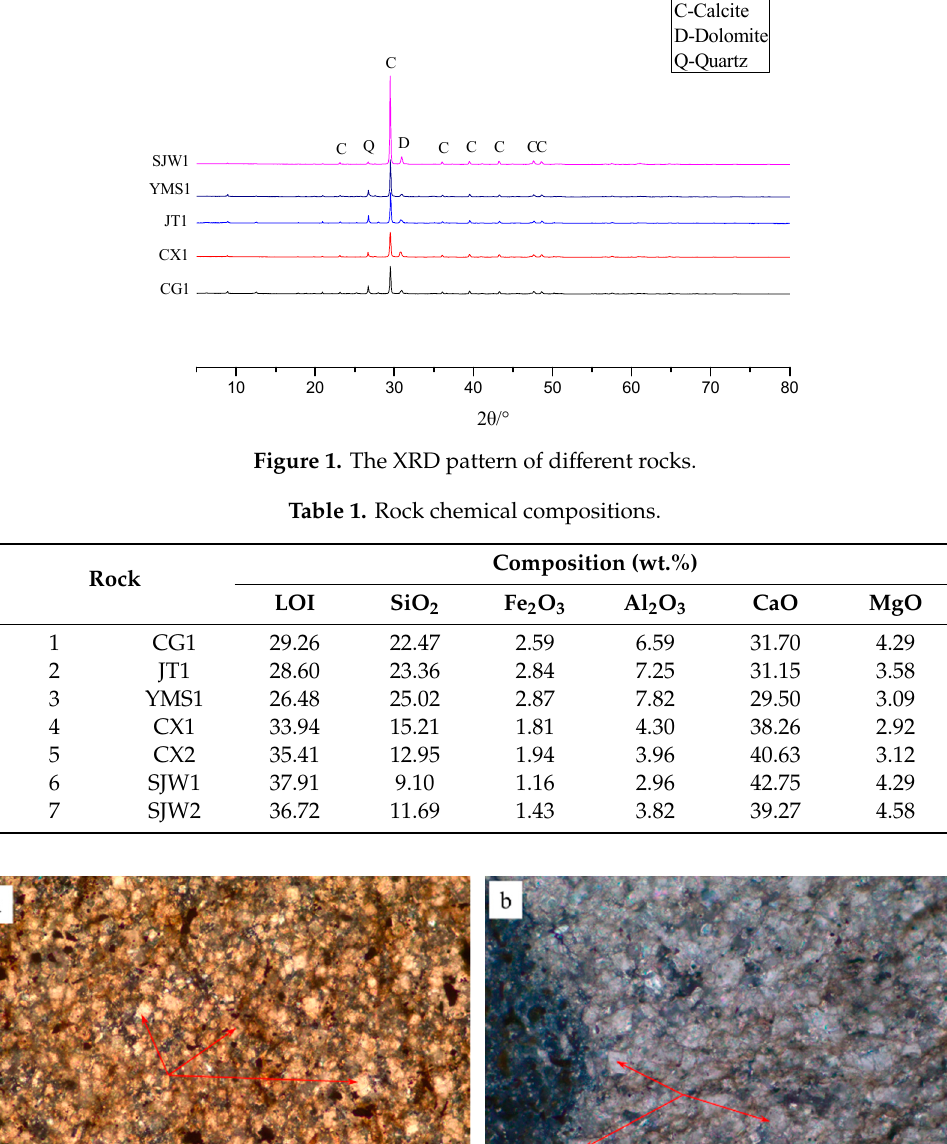
Table 3. Content of minerals in self-made cement clinker (%).